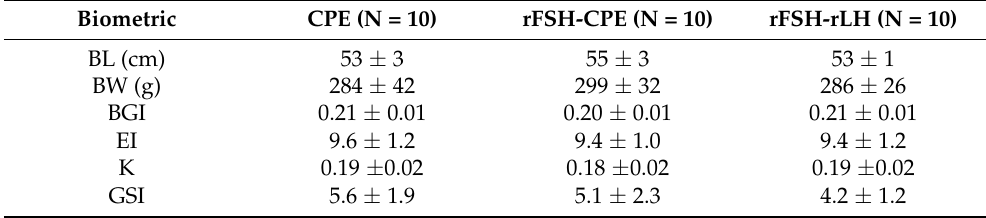
Table 2. Biometrics of the three treatment groups (CPE, rFSH-CPE and rFSH-rLH). BL, body length in cm; BW, body weight in g; BGI, body girth index; EI, eye index; K, condition factor; GSI, gonadosomatic index.